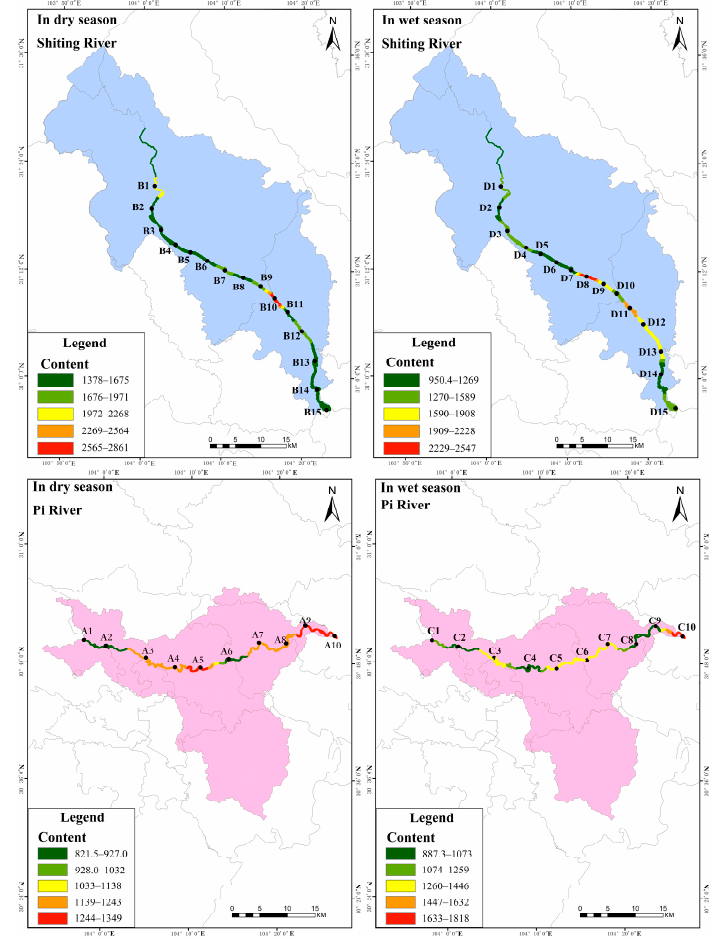
Figure 6. Spatial distribution of TP in surface sediments in the study area.